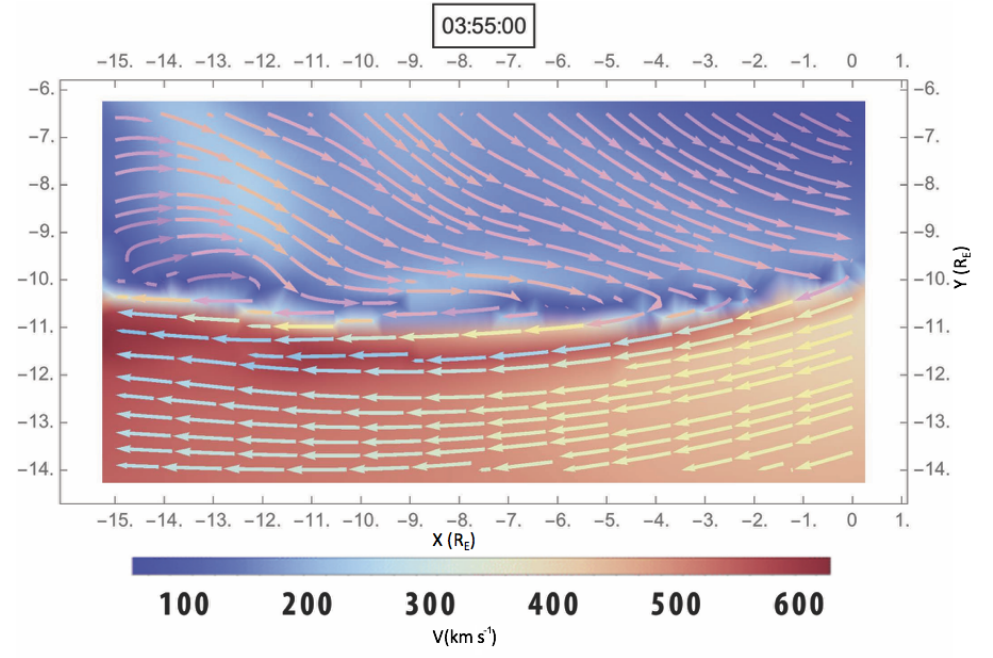
Figure 13. Output from our code that shows the velocity magnitude as the background color with no vortices detected at 03:55UTC on the X – Y plane or close